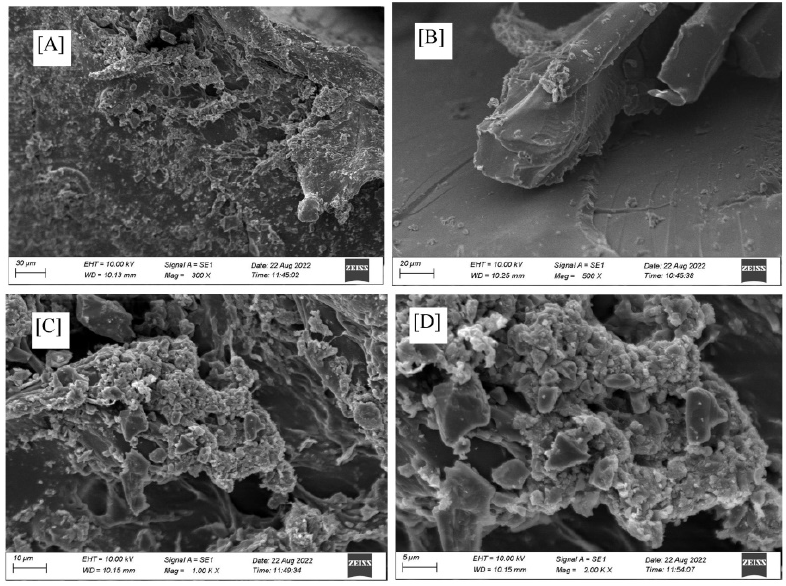
Figure 6. Superabsorbent morphology analysis using SEM with various magnifications ( A ) 300×, ( B ) 500×, ( C ) 1000×, and ( D ) 2000×.